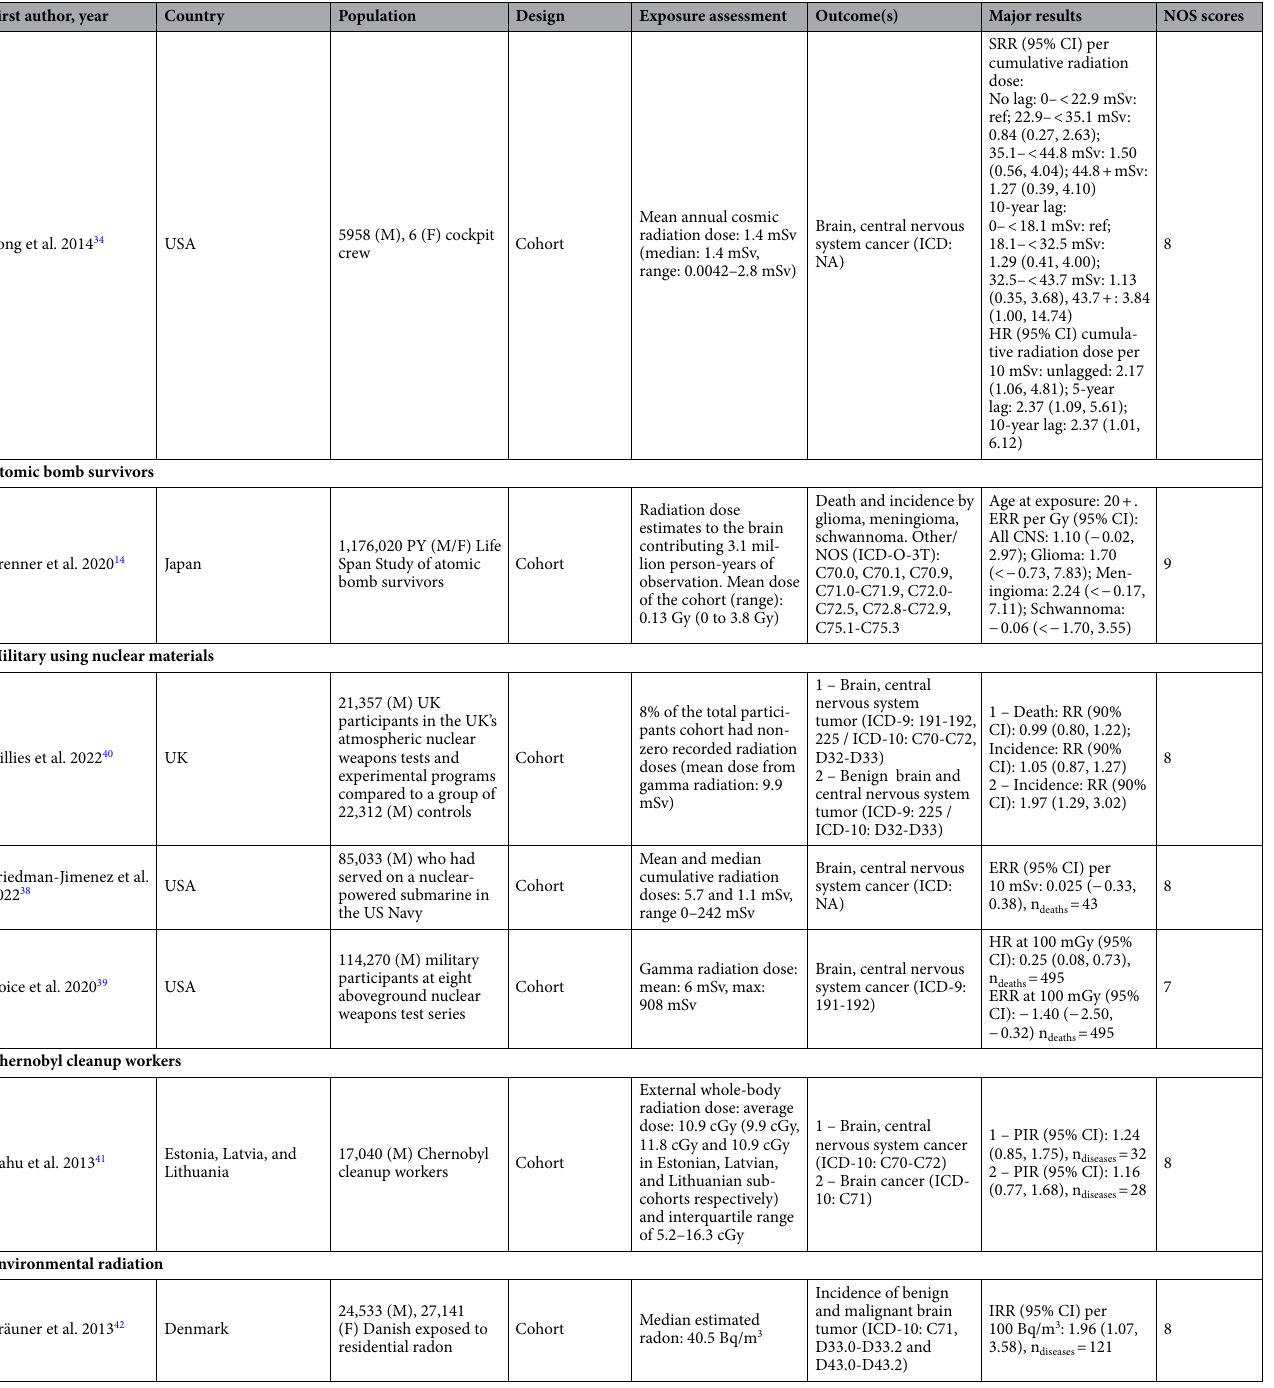
Table 1. Characteristics and key findings of the included studies on brain/CNS tumors. M Male; F Female; Gy Gray; Sv Sievert; ICD International Classification of Diseases; ICD-O International Classification of Diseases for Oncology; RR Relatif Risk; HR Hazard ratios; ERR Excess Relatif Risk; SRR Standardized Risk Ratio; PIR Proportional Incidence Ratio; NA Not Available; IQR Interquartile Range; IRR Incidence Risk Ratio; NOS Not Otherwise; Specified NOS scores scores obtained through the Newcastle Ottawa